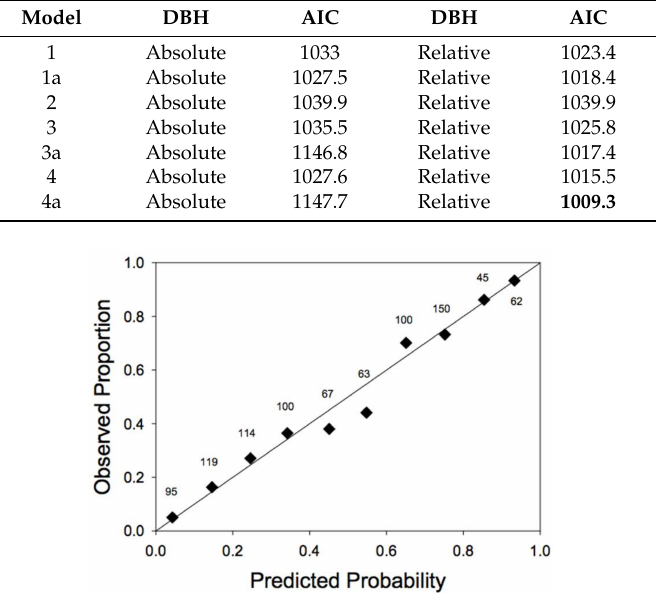
Figure 1. Goodness of fit of the analysis of the windthrow data. Plotted are the observed proportions of stems actually windthrown, as a function of the predicted probability of windthrow (using the parameters for Model 4a, reported in Table 2). The observations are divided into uniform classes of predicted probability of windthrow (0–0.1, 0.1–0.2, etc.). The numbers above each symbol give the number of observations in that class. Also plotted is a 1:1